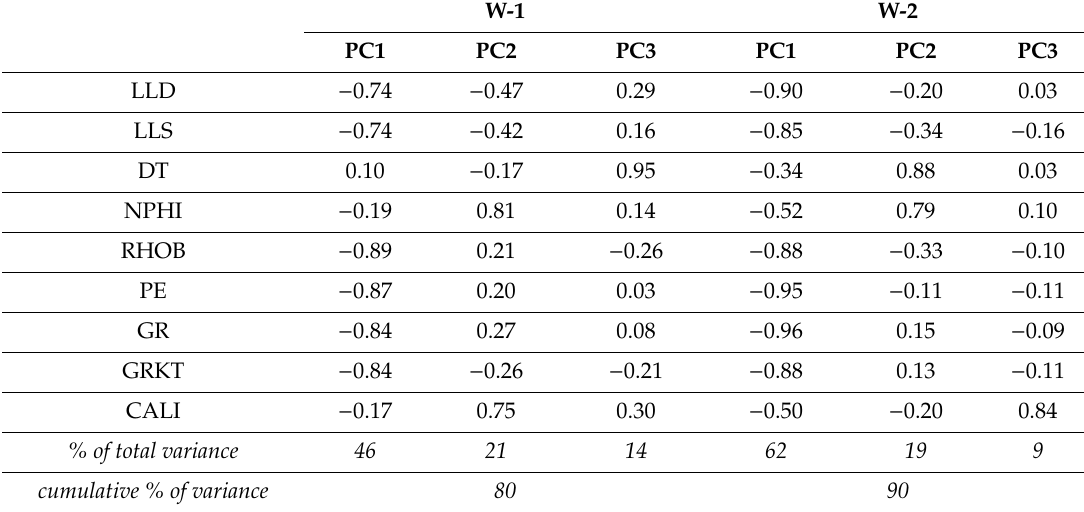
Table 2. Factor loadings for selected PCs, W-1 and W-2